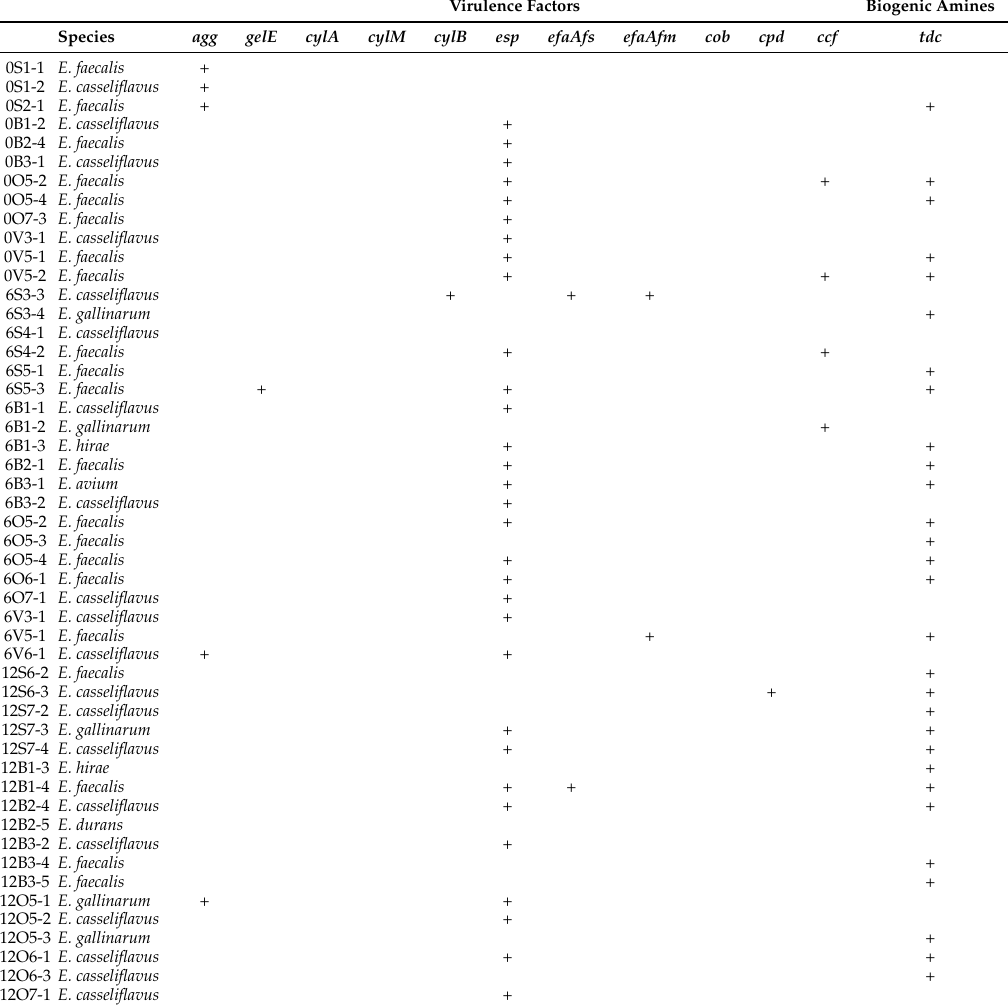
Figure 1. Bar plot of number of strains isolated within each species distributed according to time ( a ) and diet ( b ). Table 1. Detection of virulence factors and biogenic amines gene